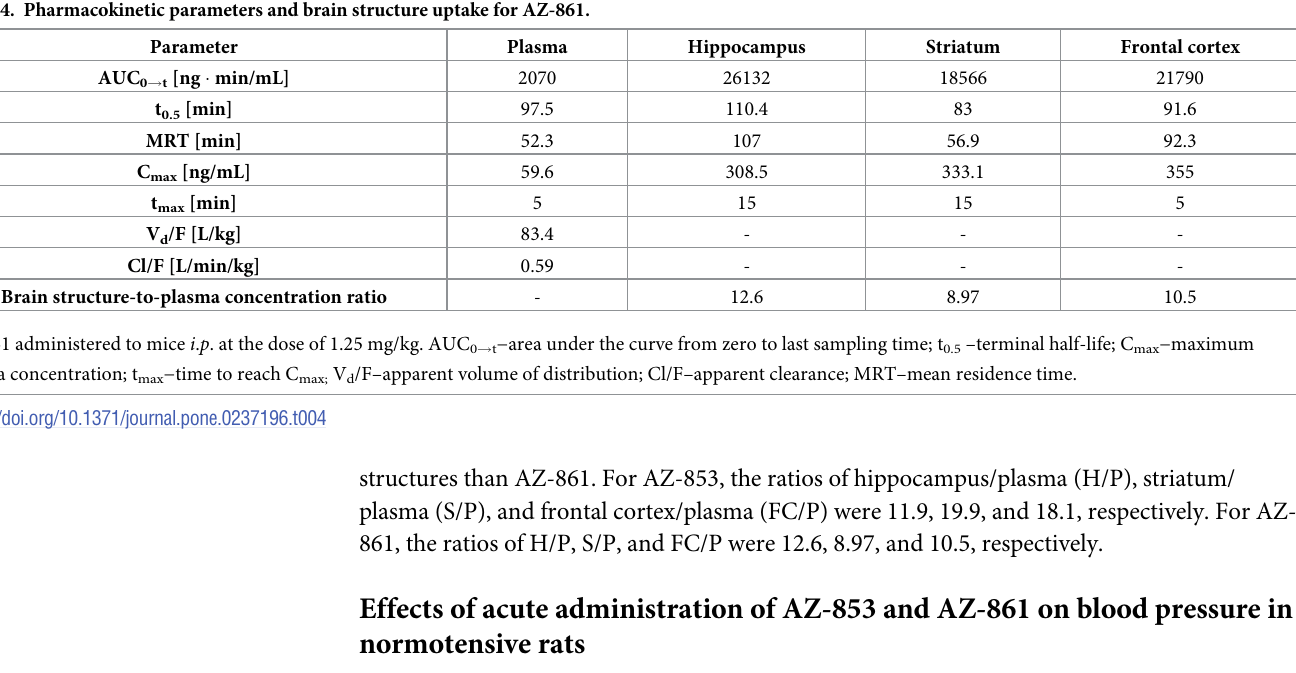
Table 4. Pharmacokinetic parameters and brain structure uptake for AZ-861. Parameter